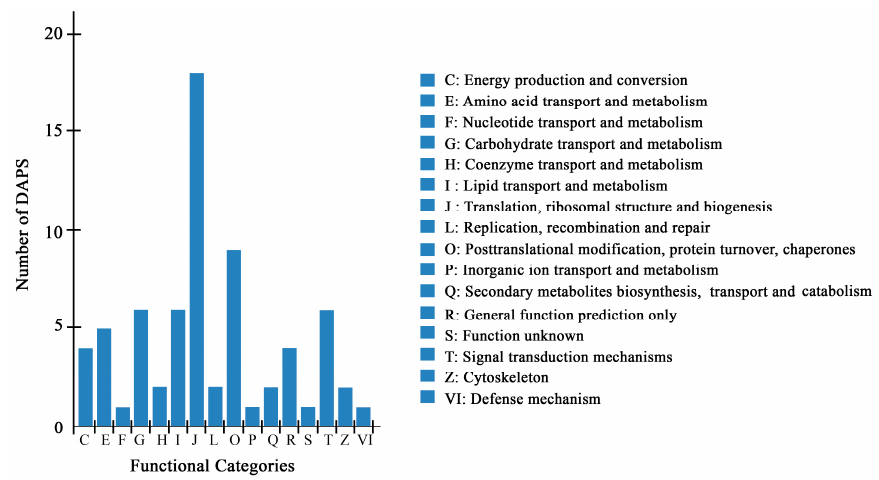
Figure 3. COG classification of DAPS identified by the iTRAQ.